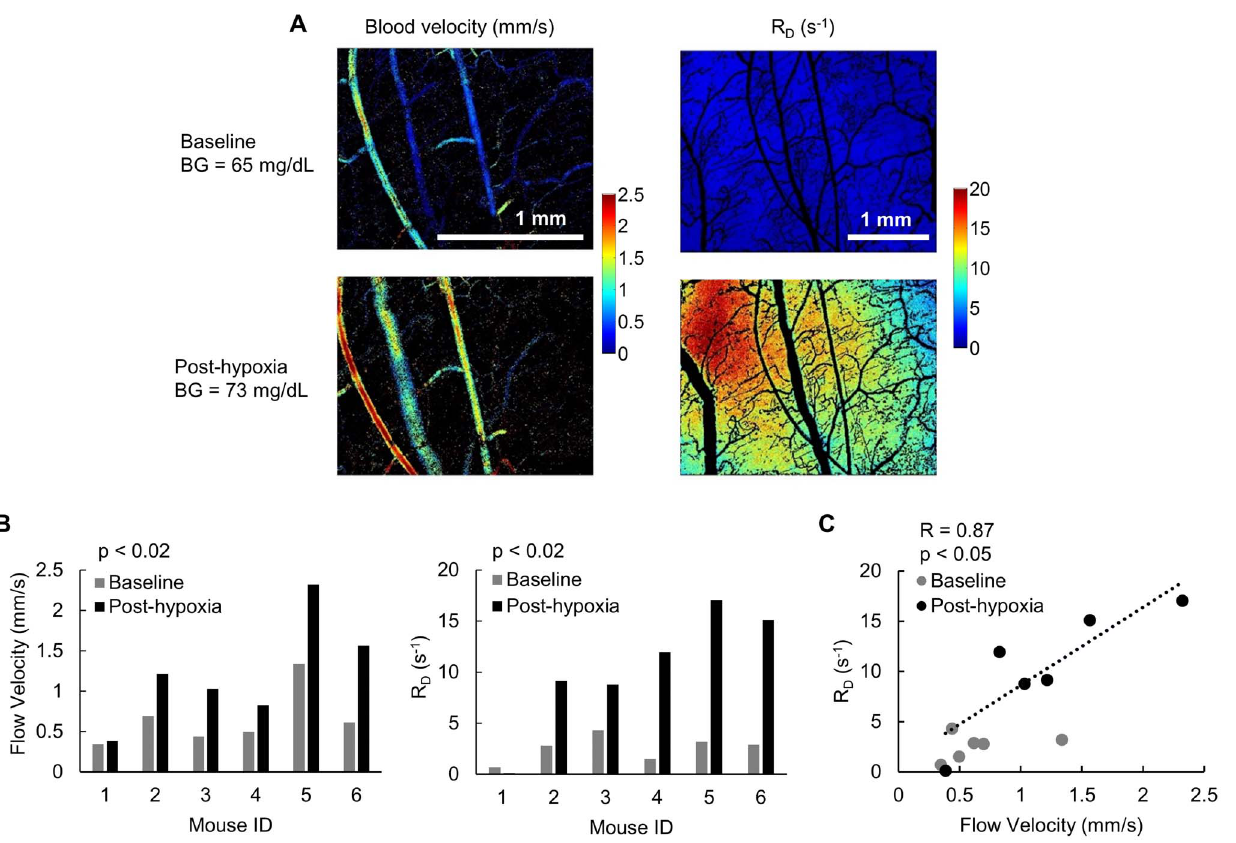
Fig. 3. The rate of 2-NBDG delivery, R D , is strongly correlated with blood velocity. (A) Representative images of blood velocity and the rate of 2-NBDG delivery (R D ) in a normal mouse at baseline and during reoxygenation after 1 hour of hypoxia. (B) Paired data for a set of mice at baseline and after 1 hour of hypoxia. After hypoxia, flow velocity and R D increased significantly (p , 0.02 for both). N 5 6 mice. (C) The rate of 2-NBDG delivery (R D ) is highly correlated with blood velocity (R 5 0.87, p , 0.05). The trendline corresponds to the trend for post-hypoxia data